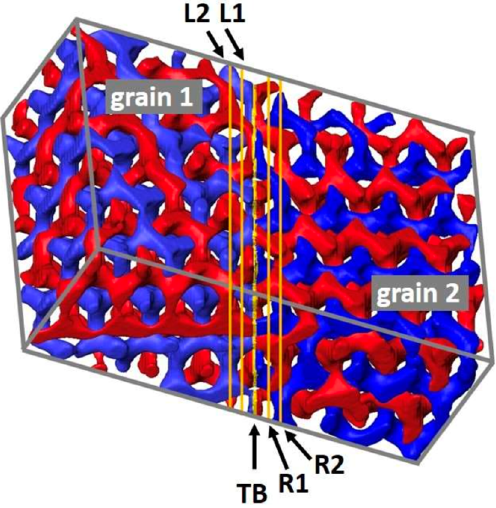
Figure 14. Reconstruction of a volume containing a Double Gyroid of PS-b-PDMS (Reprinted with permission from Ref. [183] Copyright 2021 National Academy of permission from Ref. [183] Copyright 2021 National Academy of Sciences).